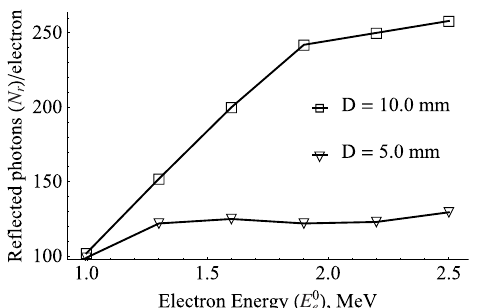
Fig. 6. Re°ected photons from a slab of thickness D ¼ 5 : 0 mm and D ¼ 10 : 0 mm and their dependence on the electron incident energy ( (cid:2) ¼ 10 : 0 mm (cid:1) 1 , a ¼ 0 : 99, g ¼ 0 :